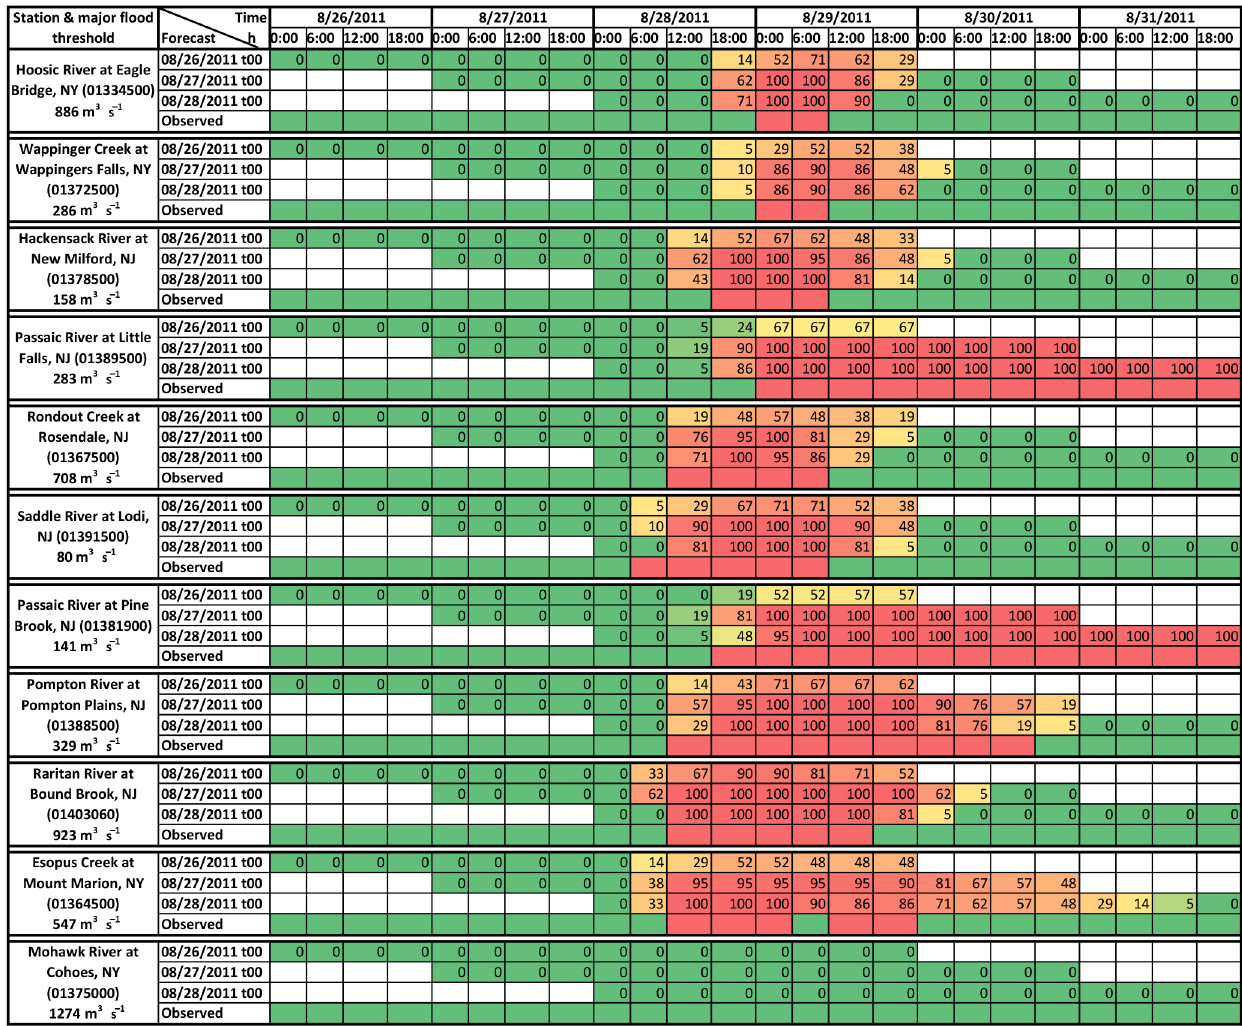
Figure 9. Color-coded threshold exceedance diagram for Hurricane Irene forecasts at 6h intervals using the major flood threshold for each USGS station. The flow values below the station ID are the major flood threshold for a given station. The x axis represents the 96h forecast horizon from the simulation date shown on the left column. The time period, in which the major event hydrological record exceeds the equivalent alert threshold, is indicated using a dark red cell, while the cell values refer to the percentage of ensemble members that were projecting a major flood. For instance, if the value is 100 then all 21 flow ensemble members are projecting a major event within a given time interval, while 0 means none of the ensemble members are exceeding the major event threshold. The observed occurrence of the threshold is exhibited at the last row for each station, the red color code indicates an observed flow higher than the major flood threshold, while the green cell indicates flow below the major threshold. Reported time is in GMT; date format is